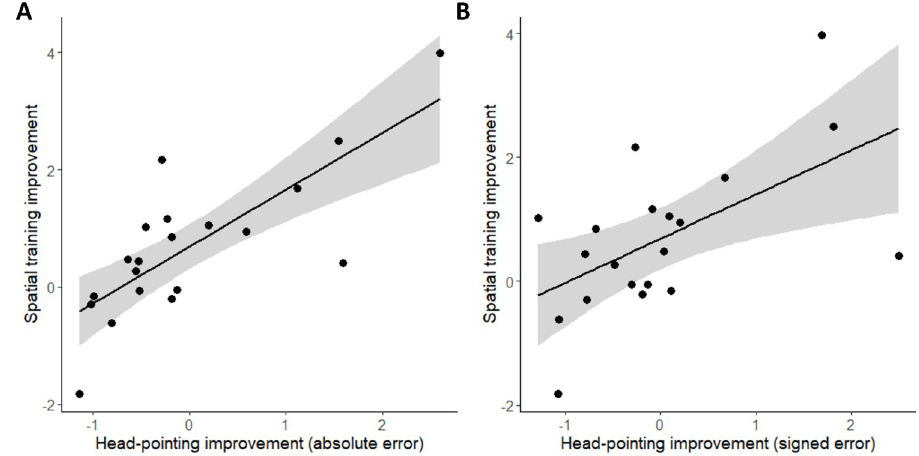
Fig 5. Correlation between the improvement in spatial training and the improvement in head-pointing sound localization, computed on absolute (A) or signed (B) errors.